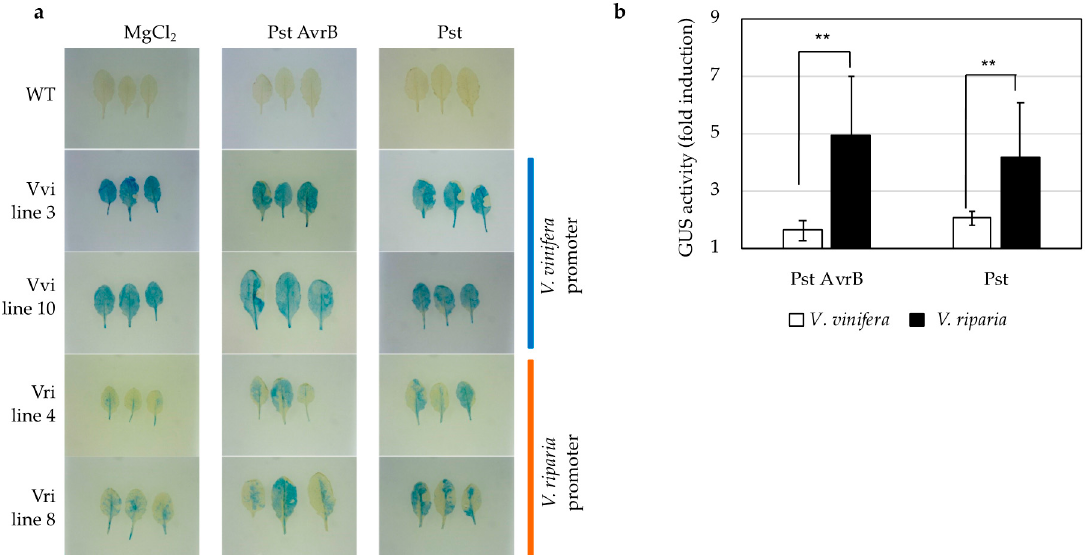
Figure 1. ATL156 promoters respond differently to pathogen infection. ( a ) β -glucuronidase (GUS) staining and ( b ) fold change in quantified GUS enzymatic activity in Arabidopsis thaliana leaves expressing the gusA gene under the control of the Vitis vinifera or Vitis riparia ATL156 promoters, 24 h after infection with an avirulent Pseudomonas syringae pv. tomato (Pst DC3000) strain carrying the avirulence AvrB gene (Pst AvrB) or a virulent strain of Pst DC3000. Values are means of three biological replicates ± SE and statistically significant differences calculated with Student’s t -test are indicated as **, p ≤ 0.01.